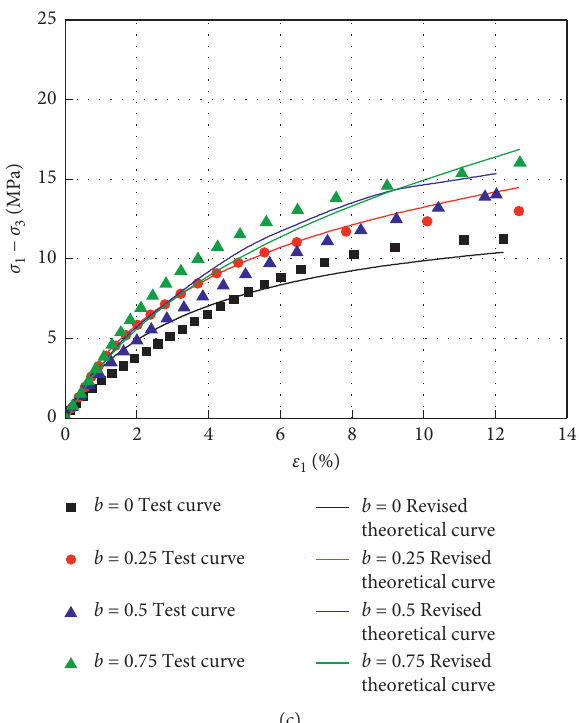
Figure 12: Test curve and modified theoretical curve at different temperatures and medium principal stress coefficients. (a) − 5 ° C. (b) − 10 ° C. (c) − 15 °